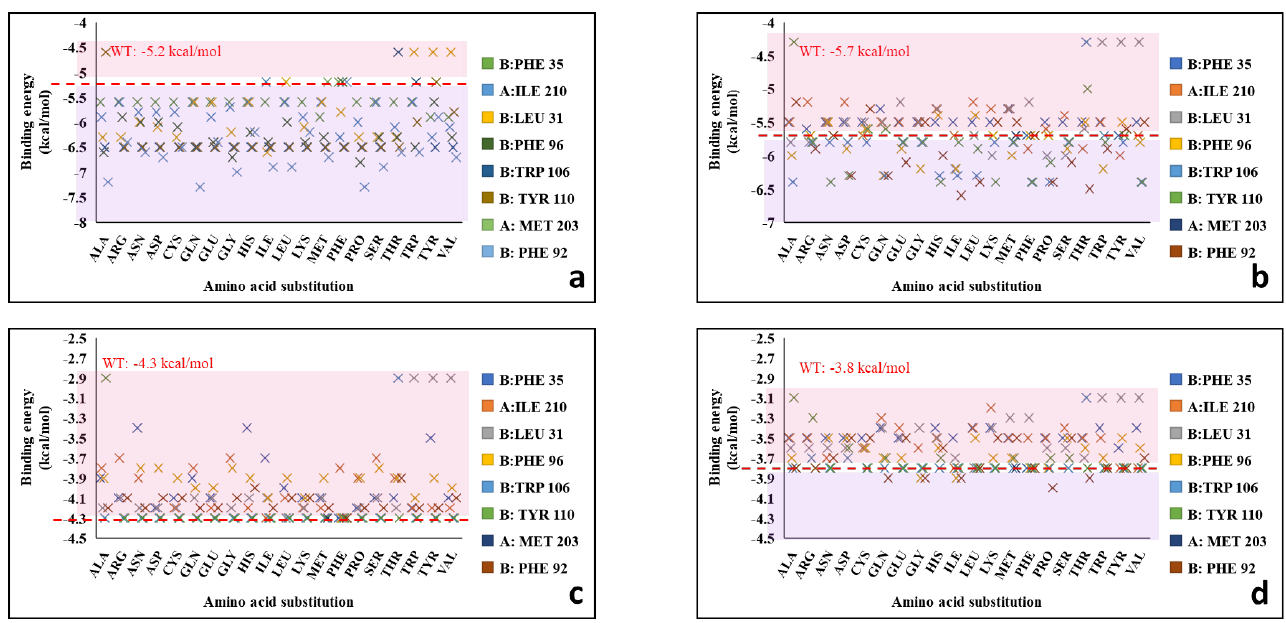
Figure 7. The binding energy plots between the mutants and their binding energies with ( a ) ethylbenzene, ( b ) toluene, ( c ) 1,3-butadiene, and ( d ) trichloroethylene.